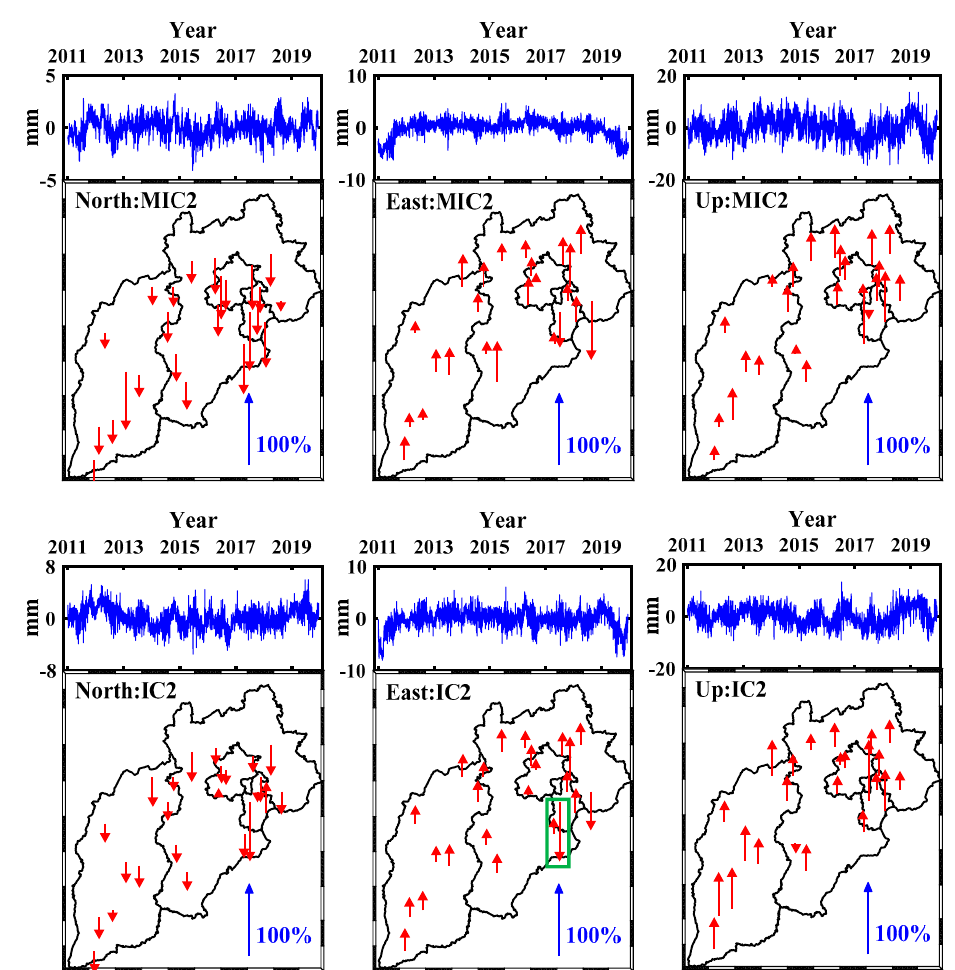
Figure 7. The second MICs and ICs for the three coordinate components. ( Top ) scaled TRs and ( bottom ) normalized SRs.